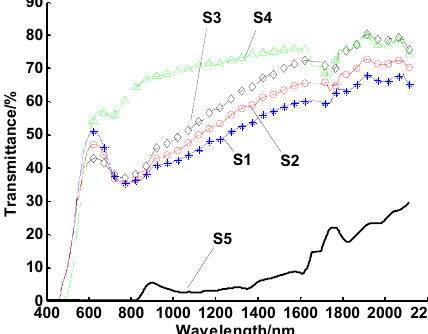
Figure 4. Spectral transmittances of CuO/oil nanofluids for a number of thermal cycles. Note: samples 1–4 experienced 5, 10, 25, and 45 thermal cycles, respectively, while sample 5 underwent no thermal cycle.